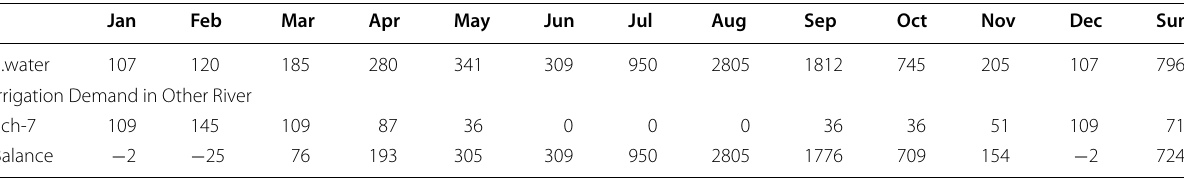
Table 11 Monthly water balance other rivers (‘000 m3)